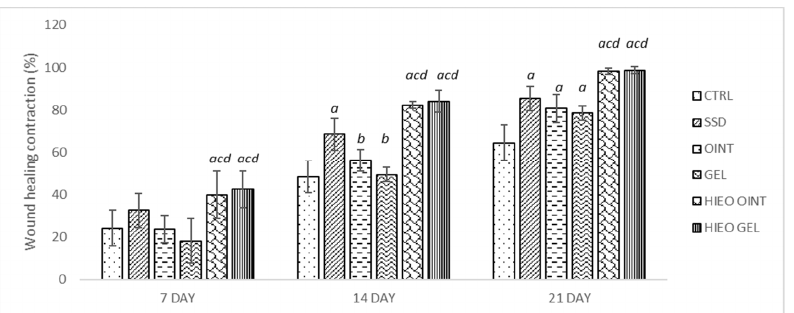
Figure 1. Percentage wound contraction based on treatment. Values are presented as mean ± stand ‐ ard deviation. Values p < 0.05 were considered to be statistically significant. a Statistical significance in relation to CTRL group; b Statistical significance in relation to SSD group; c Statistical significance in relation to OINT group; d Statistical significance in relation to GEL group; CTRL—negative con ‐ trol group; SSD—1% silver sulfadiazine group; OINT—ointment base group; GEL—gel base group; HIEO OINT— H. Italicum essential oil ointment group; HIEO GEL— H. Italicum essential oil gel group.